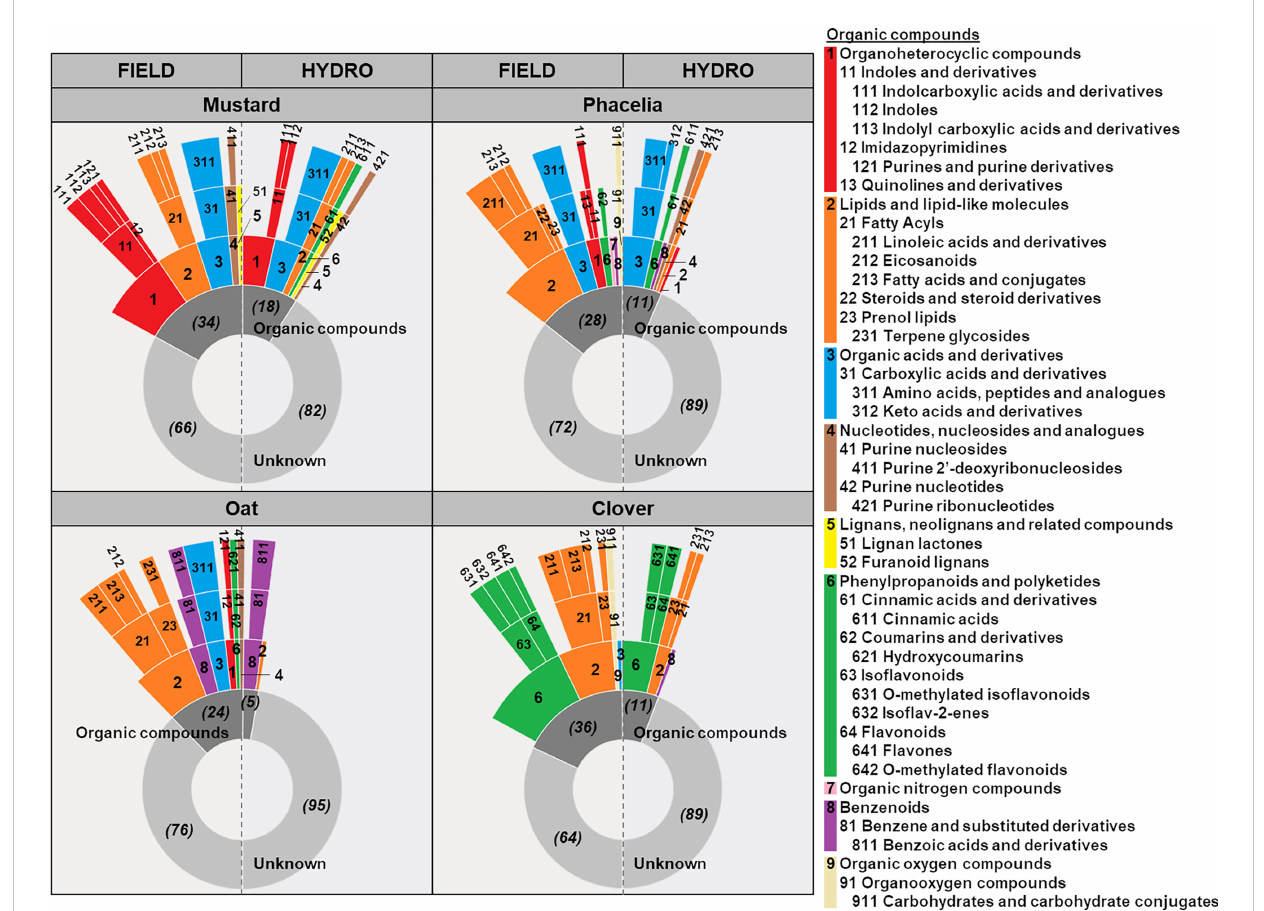
FIGURE 4 Putative chemical classi fi cation of the 100 most abundant features in root exudates of mustard, phacelia, oat and clover grown in the fi eld (FIELD) or hydroponically (HYDRO). Features were sorted by peak height and the top 100 in either growth condition are shown in Table S1. Those were classi fi ed using the ClassyFire tool (http://classy fi re.wishartlab.com; Djoumbou Feunang et al. (2016)) by their kingdom and superclass , when compounds could be putatively annotated by level 3, and by kingdom , superclass , class and subclass , when putative annotation could be made on level 1 and 2 (see Table S1). Figure legend shows superclass on rank 1 (e.g. 1 Organoheterocyclic compounds), class on rank 2 (e.g. 11 Indoles and derivatives) and subclass on rank 3 (e.g. 111 Indolcarboxylic acids and derivatives). Features without annotation were classi fi ed as “ Unknown ” .